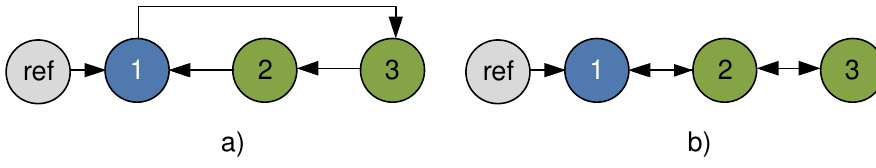
Figure 1. Information flow configuration: ( a ) cyclic topology; ( b ) chain topology. The gray circle represents the leader agent and white circles are